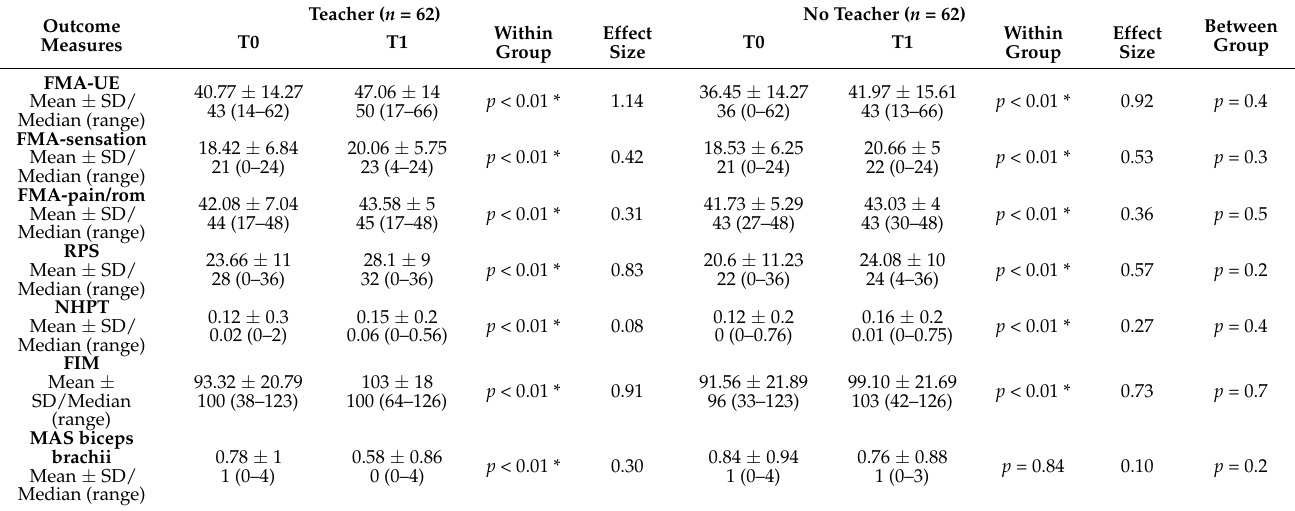
Table 2. Descriptive and inferential analysis of teacher and no-teacher groups at baseline (T0) and after treatment